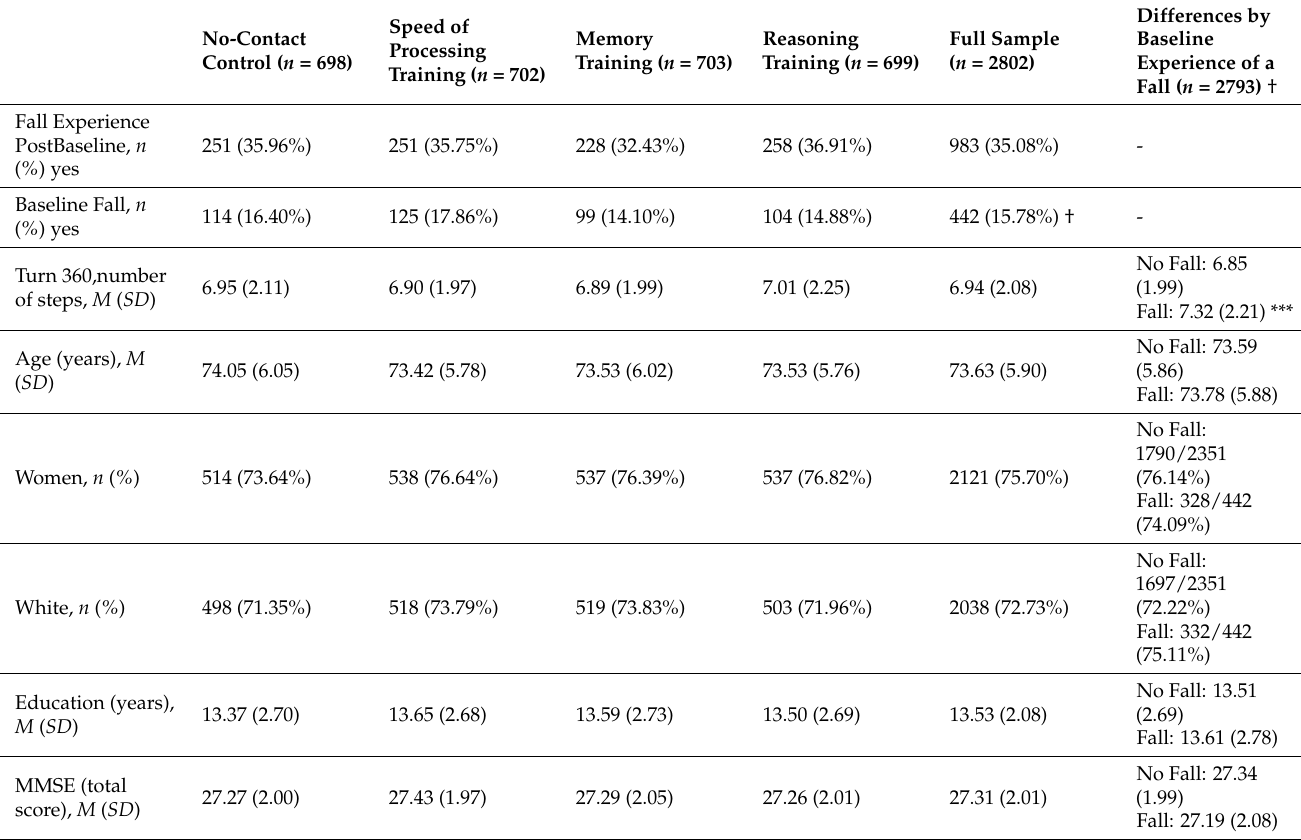
Table 1. Baseline characteristics and group differences by baseline experience of a